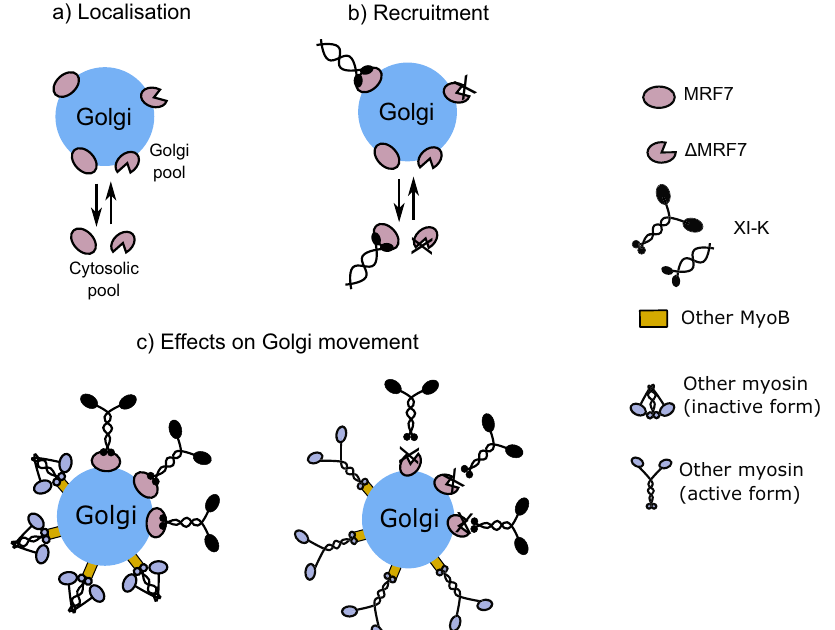
Fig. 8 Suggested model for MRF7 Golgi localisation, myosin recruitment and effects on Golgi movement. a MRF7 and its N-terminally truncated version, Δ MRF7, localise to the Golgi surface and in the cytoplasm. As a soluble protein, this suggest that MRF7 could have the ability to cycle on and off the Golgi surface. The MRF7 Golgi localisation was determined to be driven by its C-terminal domain. b The DUF593 domain is essential for myosin recruitment and binding. As the interaction between XI-K tail and MRF7 takes place both on the Golgi membrane and in the cytosol, we suggest that the interaction could initially take place in the cytosol and trigger XI-K recruitment to the Golgi. c Effects of GFP-MRF7 and GFP- Δ MRF7 over-expression on Golgi movement. Golgi movement is preferentially driven by myosin XI-K (black). Other MyoB receptors could be associated to the Golgi and bind myosins kept in the inactive form (blue). Deletion of the DUF593 domain impairs the binding of MRF7 to XI-K; in this scenario the other MyoB receptor would be responsible for driving Golgi